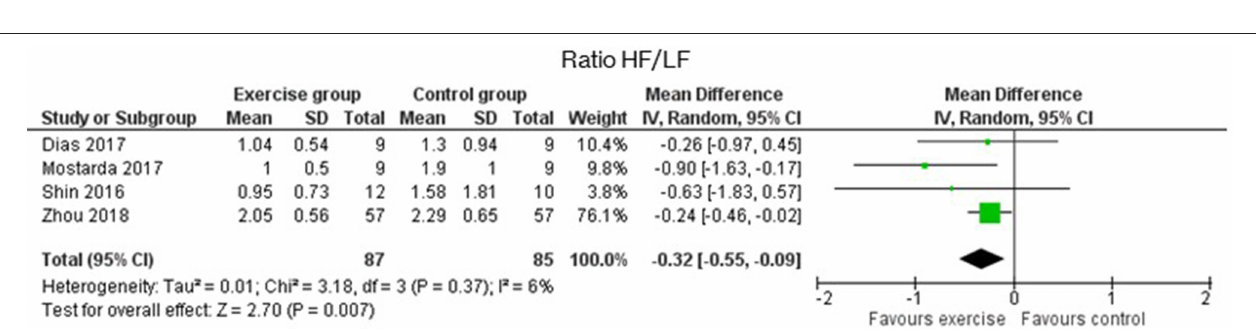
FIGURE 5 | Effects of exercise in LF (Low Frequency) heart rate variability measure expressed in absolute (ms 2 ) and relative (n.u) power.